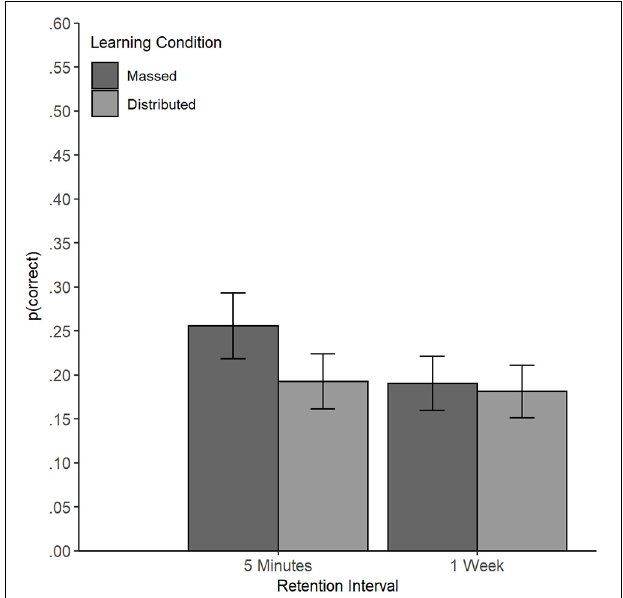
FIGURE 2 | Interaction of Learning Condition and Retention Interval in Experiment 1. Learning outcomes (text comprehension) by learning condition at the short and long retention interval in Experiment 1 (estimated based on Model 1, back-transformed probability of a correct answer). Error bars represent standard errors ( ± 1